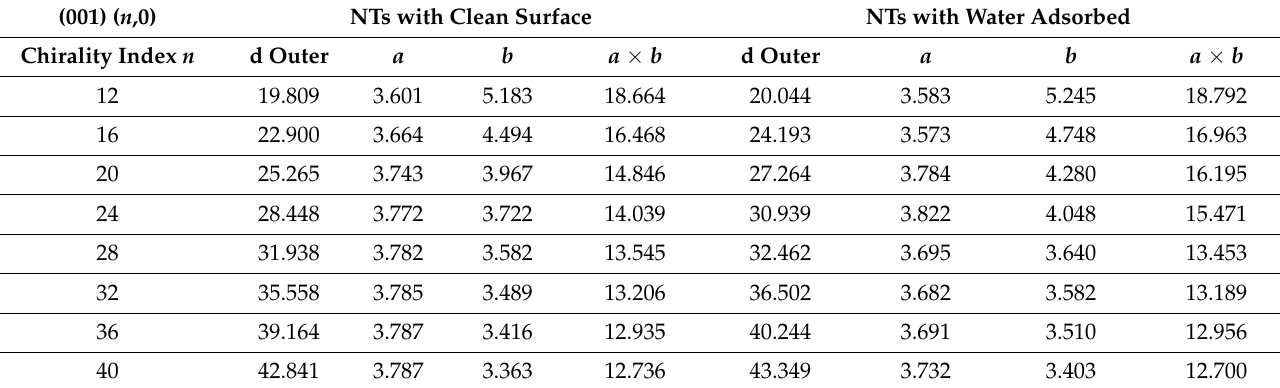
Table 3. Parameters of 6-layered (001) ( n ,0) TiO 2 NTs, simulated with and without water. The lattice parameter correspond- ing to the NT axis is denoted with a , d stands for outer diameter, b —for outer b constant along NT circumference, and a × b —their product.